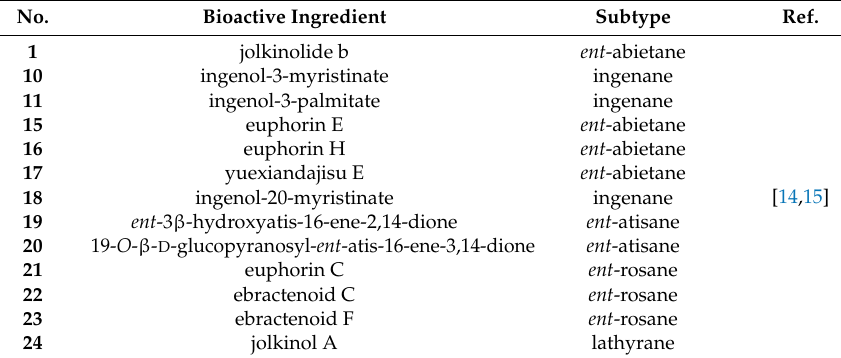
Table 2. Diterpenoids from E. fischeriana inhibiting mammosphere formation in MCF-7 cells.